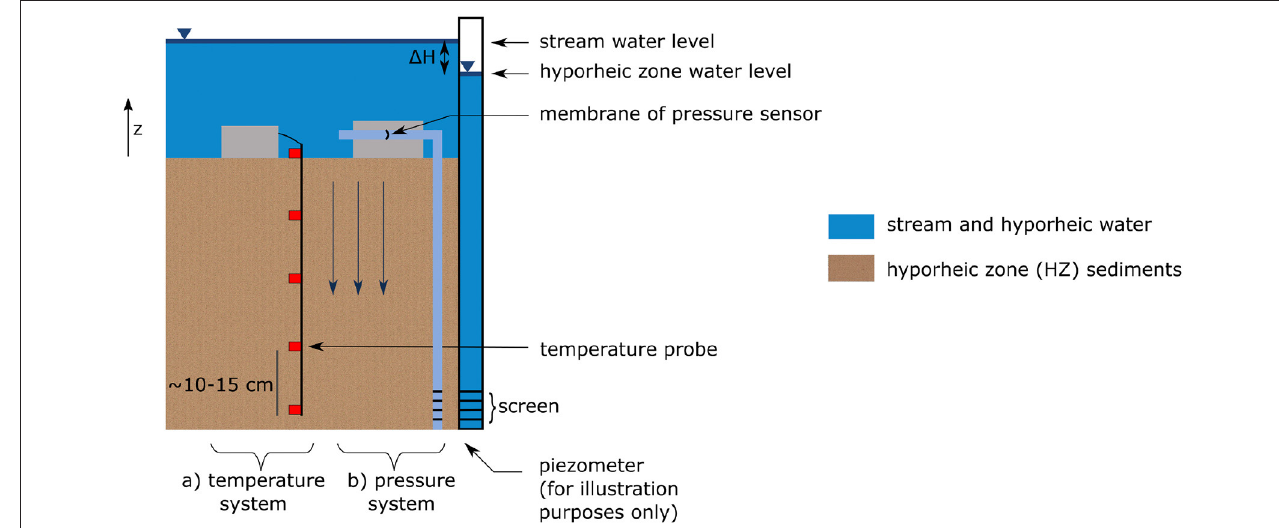
FIGURE 1 | Cross-sectional view of the LOMOS-mini monitoring system. It consists in vertically-distributed temperature sensors (in red) and a hydraulic head difference sensor. Reproduced from Cucchi et al. (2018).